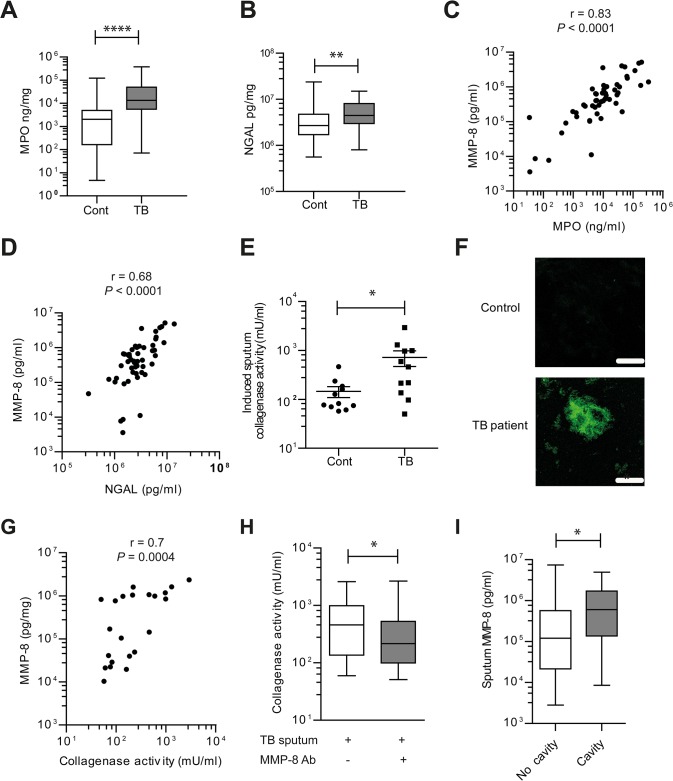
Induced sputum samples of pulmonary TB patients have increased collagenase activity due to neutrophil-derived MMP-8.(A and B) Induced sputum MPO and NGAL was analyzed by ELISA from n = 51 TB patients and n = 57 healthy controls. MPO and NGAL were increased in patients with pulmonary TB. (C and D) Induced sputum MMP-8 closely correlated with both MPO and NGAL in TB patients, performed using Spearman’s correlation coefficient. (E) Induced sputum collagenase activity is increased in TB patients. (n = 11 each group). Subsets analyzed were representative of the whole cohort analyzed by Mann-Whitney test. (F) Confocal microscopy shows increased DQ collagen degradation in induced sputum of TB patient relative to control. Image is representative of n = 3 each group. Scale bars represent 50μm. (G) Induced sputum MMP-8 and collagenase activity correlate, analyzed by Spearman’s correlation coefficient (n = 22). (H) MMP-8 neutralization suppresses induced sputum collagenase activity from TB patients. MMP-8 neutralizing antibody was added to activated induced sputum with Type I DQ collagen (n = 11). Box and whiskers represent 10–90th percentile with comparison using Wilcoxon-Sign rank test. (I) Induced sputum MMP-8 were higher in patients with pulmonary cavities than those without. * P< 0.05, **P<0.01, ****P<0.0001.